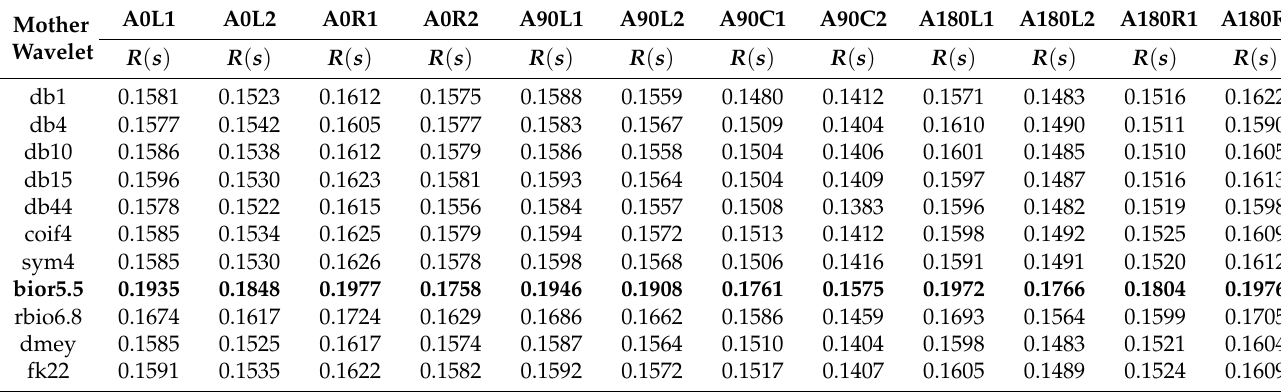
Table 6. Results of 11 mother wavelet functions for 12